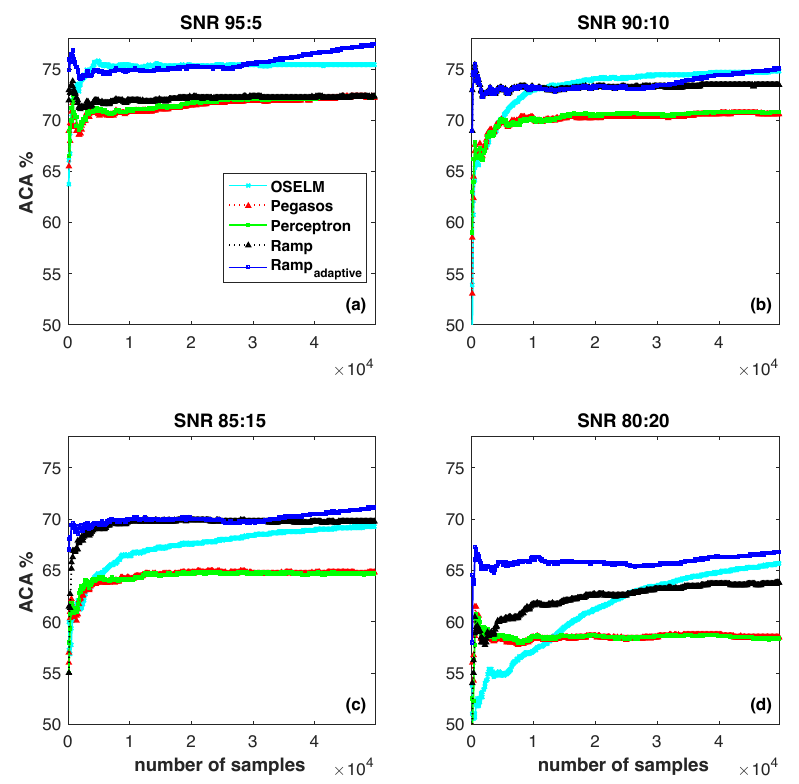
Figure 7. Comparison of online learning algorithms w.r.t. average classification accuracy on synthetic data sets: ( a ) SNR 95:5; ( b ) SNR 90:10; ( c ) SNR 85:15 and ( d ) SNR